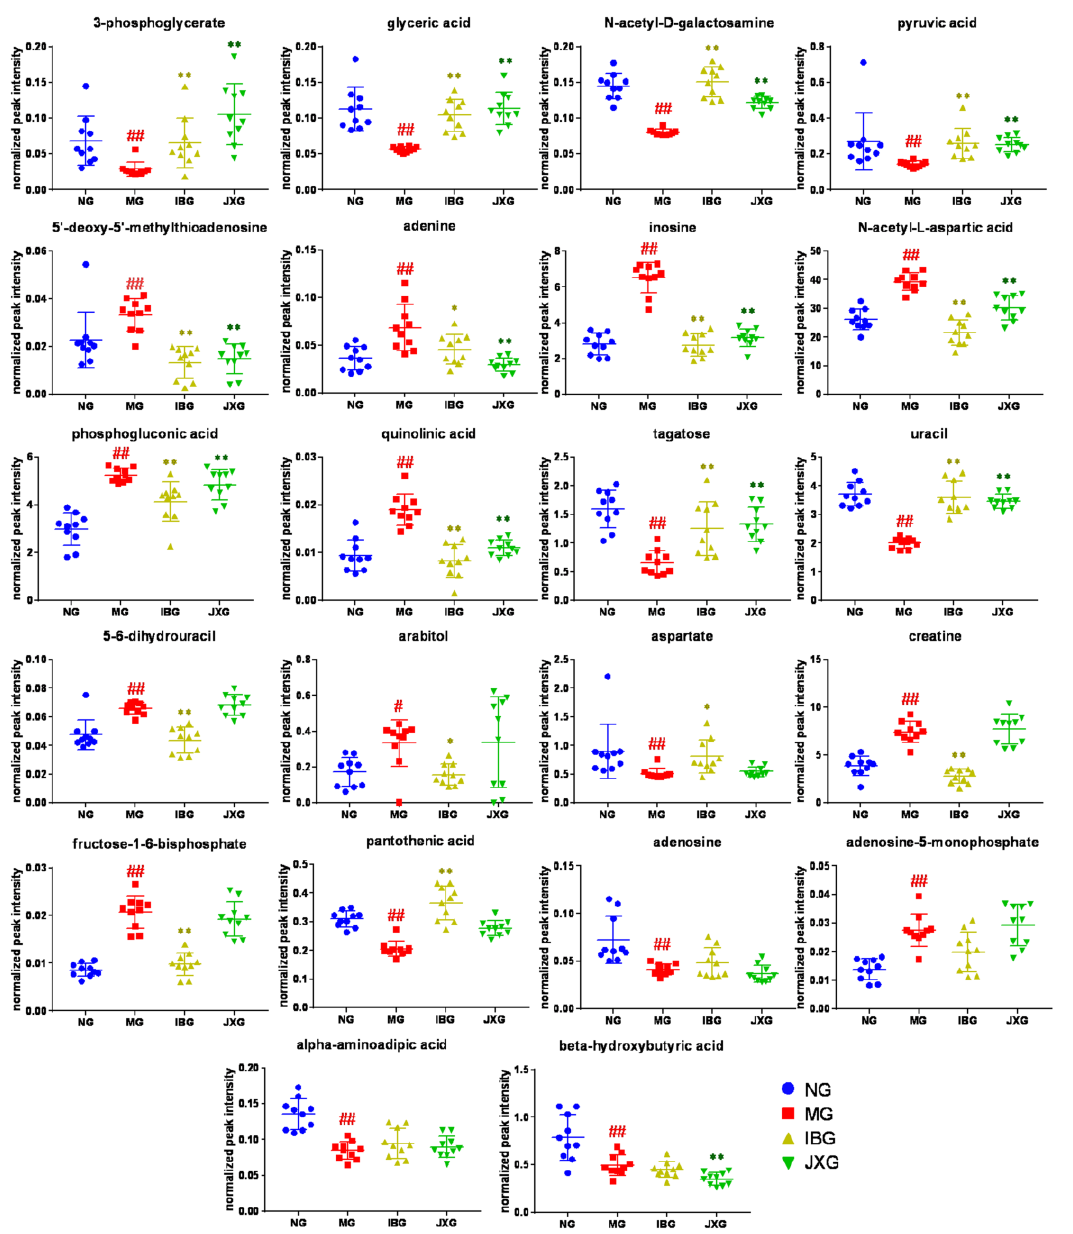
Figure 4. Scatter plots of significantly changed metabolites’ normalized peak intensity in rat brain samples. The x-axis shows the specific metabolite’s normalized peak intensity, and each scatter represents a rat brain sample. represents brain samples of NG, represents brain samples of MG, represents brain samples of IBG, and represents brain samples of JXG. The scatter plots show the mean and SD of the metabolites. # p < 0.05, ## p < 0.01, vs. NG; * p < 0.05, ** p < 0.01, vs. MG.